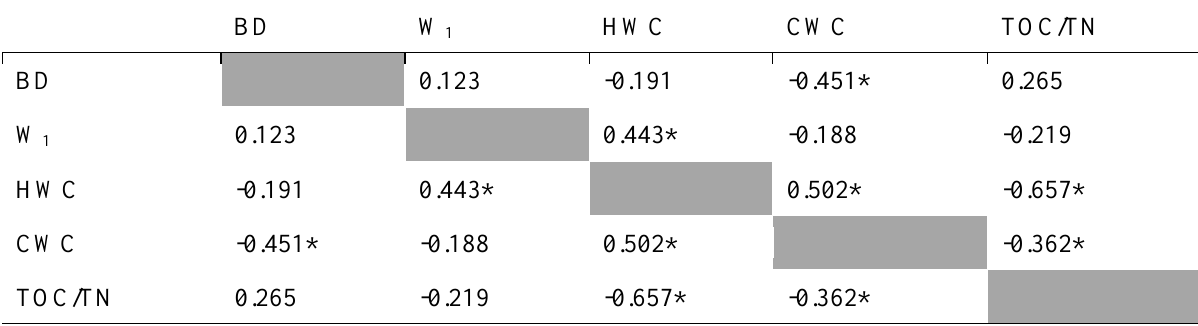
Table 2. Pearson coefficients of correlations between selected soil properties (n = 70). Key: BD = bulk density; * = significant at p =